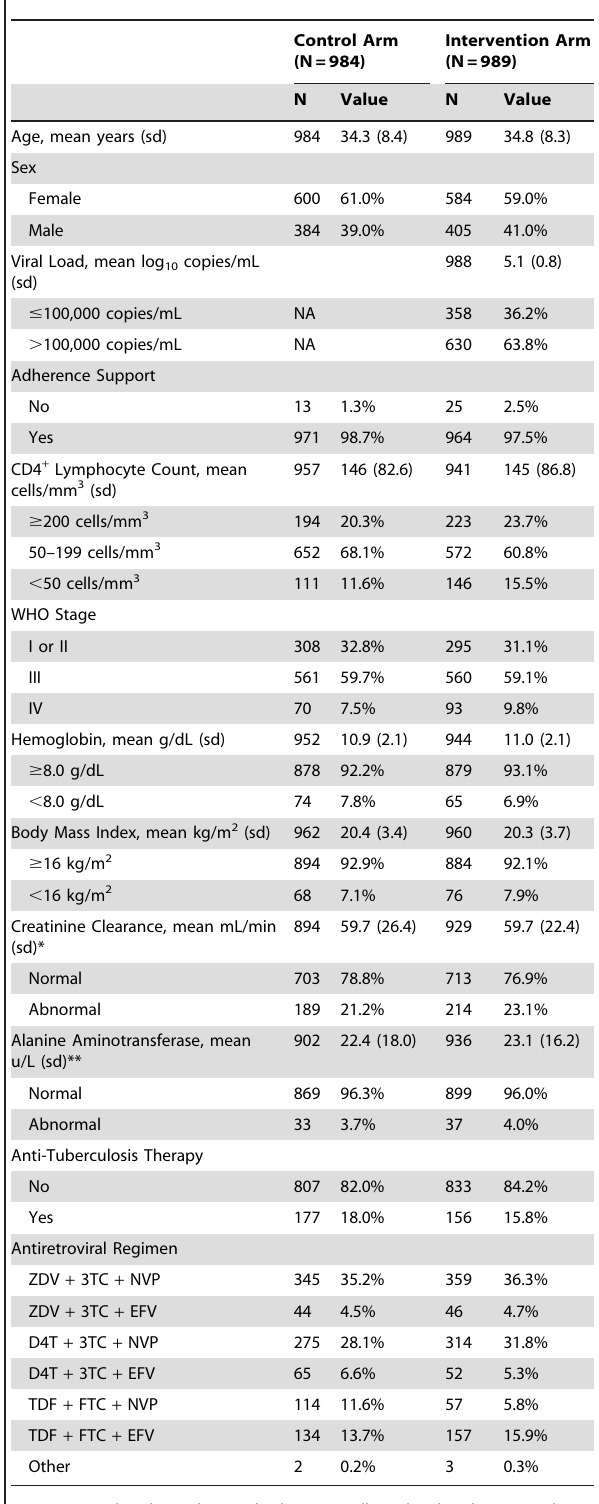
Table 2. Baseline characteristics of participants by study